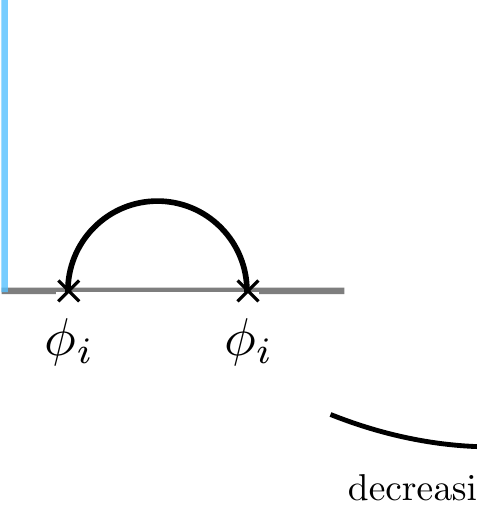
Figure 11 . The geodesics approximation of a two-point function on a half plane. The blue lines show the brane configurations. The left figure shows the zero tension case. By decreasing the brane tension to a negative value, there is a possibility that a part of the geodesics is excluded by the end-of-the-world